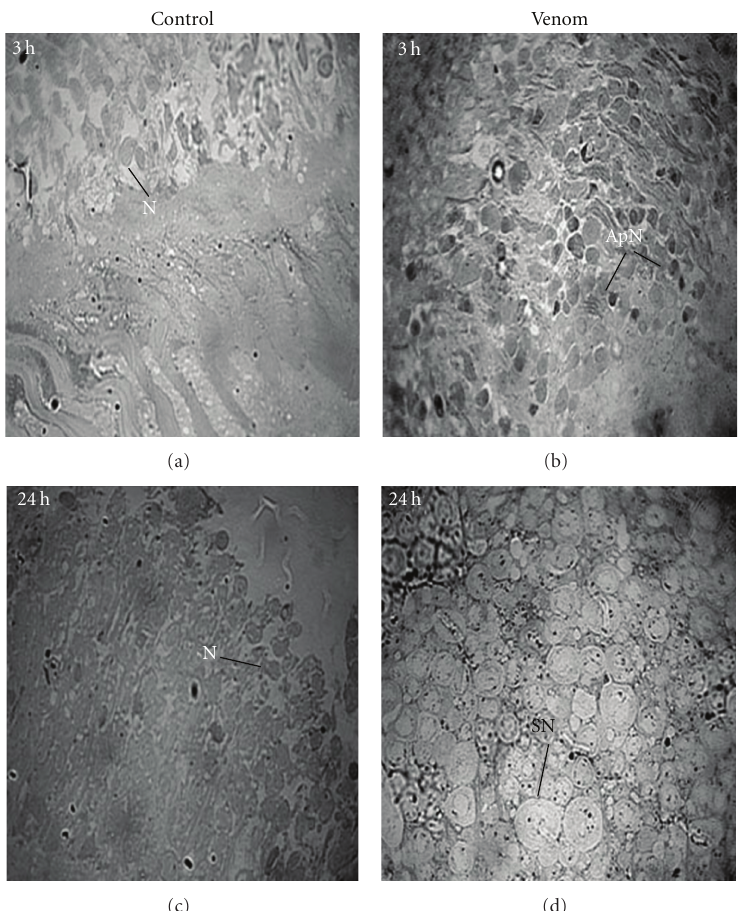
Figure 3: Light micrographs showing apoptosis in brain tissue of S. bullata following envenomation by N. vitripennis . Detection of apoptotic (ApN) or nonapoptotic neurons (N) relied on in situ labeling based on the TUNEL assay. Apoptotic cells are evident as darkly stained cells (peroxidase) in each panel. Several swollen neurons (SNs) were evident by 24 postenvenomation. Brain tissue extracted from nonparasitized flies served as controls. Magnification is 750x.